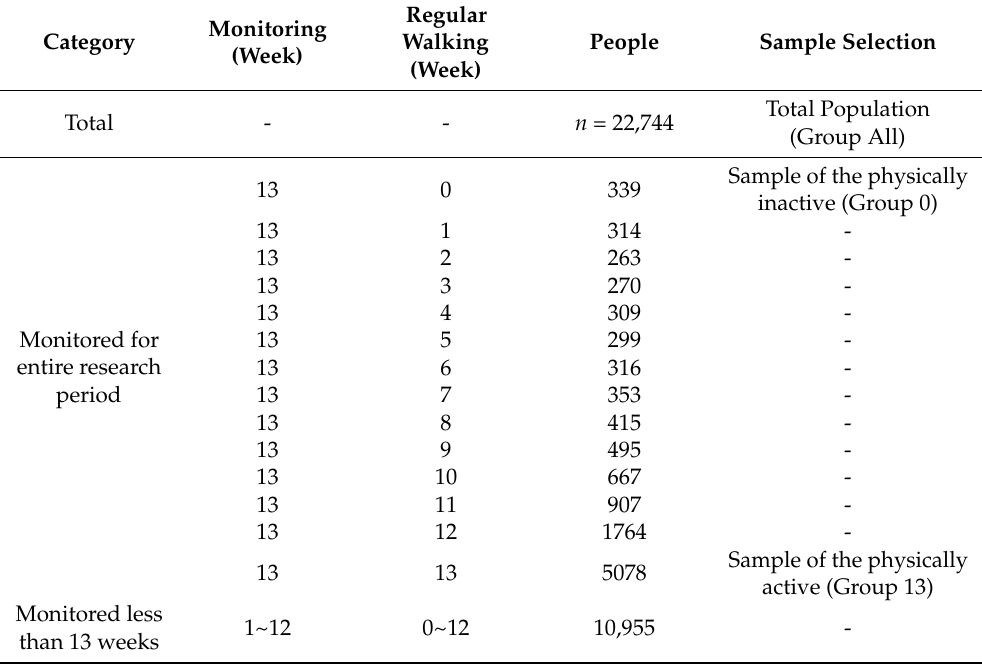
Table 1. Distribution of regular walking by week and sample